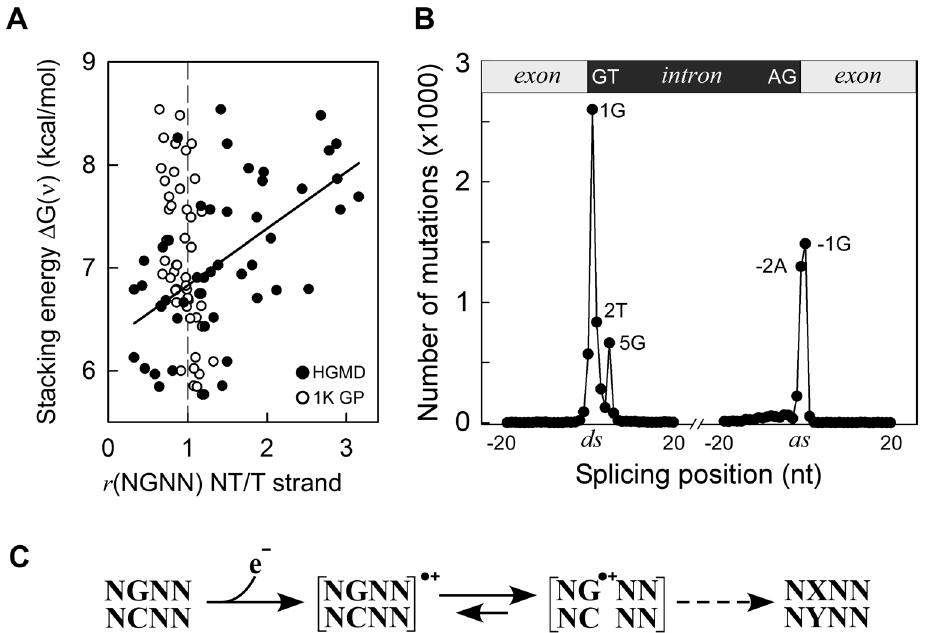
Figure 3. Germline mutations are affected by transcription. Panel A , HGMD dataset; y-axis , as in Figure 1C; x-axis , ratio of mutated NGNN sequences in protein coding genes containing the P2-guanine base on the non-transcribed ( NT ) vs . transcribed ( T ) strand; solid circles , HGMD dataset ( r 2 0.32, P( a ) 0.05 0.991, P , 0.001); open circles , 1000 Genomes Project dataset. Panel B , inherited splicing mutations dataset; top , cartoon of exon-intron boundaries showing the conserved GT and AG bases at the donor ( ds ) and acceptor ( as ) splice sites; bottom , graph of splicing mutations; y-axis , number of SBSs; x-axis , position of SBSs relative to + / 2 20 nt of splice junctions; Panel C , model for sequence-dependent SBSs in cancer and human inherited disease. In the first step, an electron is lost from within a tetranucleotide sequence, leaving a hole. In the second step, the hole migrates to and from various competing sites, including nearby bases and chromatin-associated amino acids (not shown), eventually being trapped by a guanine base. The resulting guanine radical cation either causes DNA-protein crosslinking or undergoes subsequent chemical modifications. If the modified base is not corrected by DNA repair, it may give rise to a mutation (X-Y base-pair) as a result of error-prone DNA polymerase synthesis during DNA replication (dashed